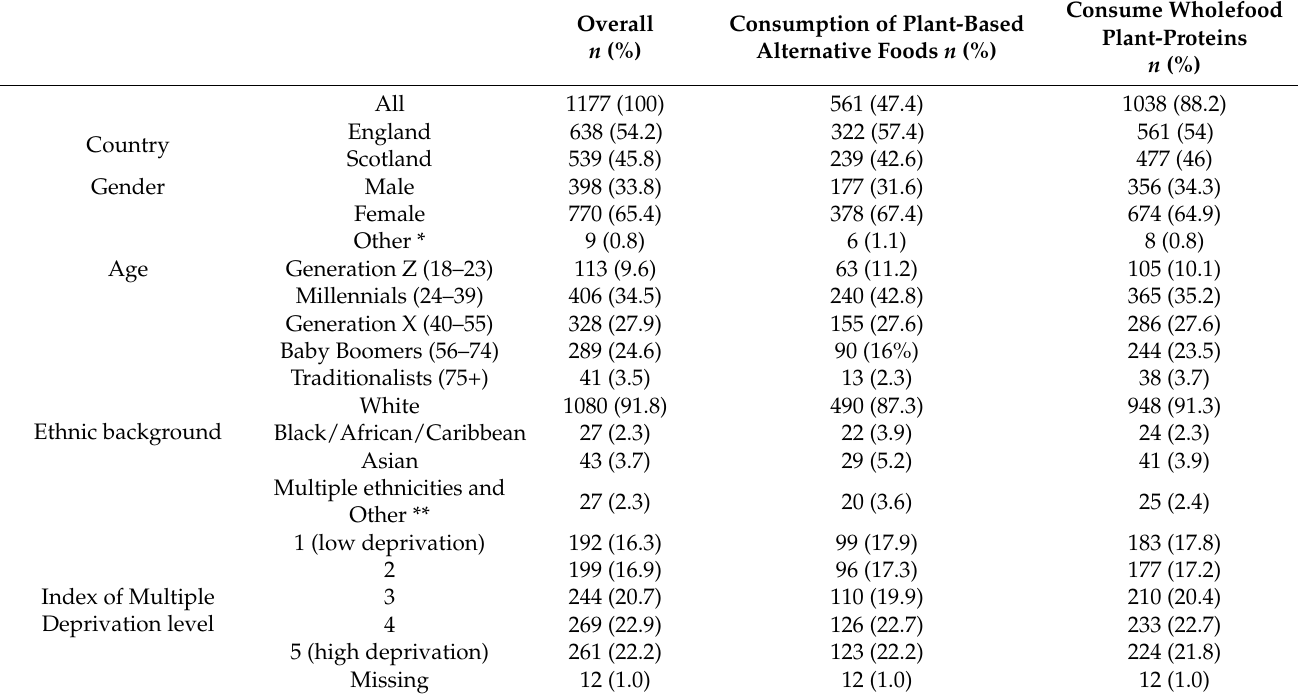
Table 1. Participant